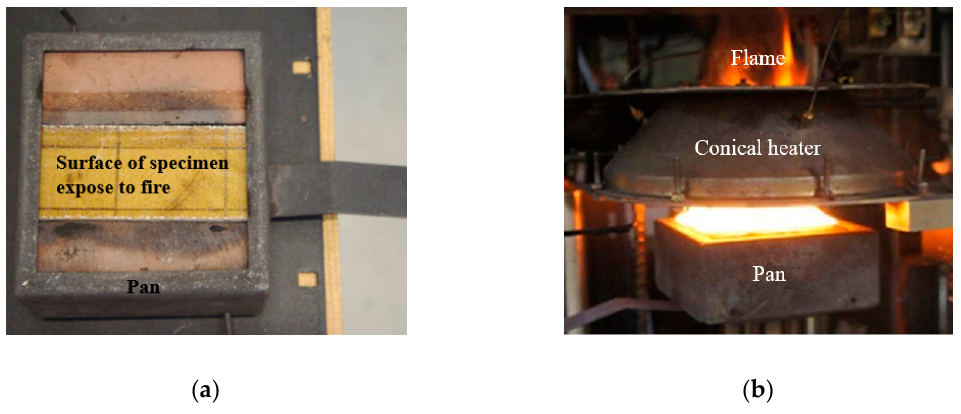
Figure 2. Diagram of the ATLAS cone calorimetry: holder of the test specimen ( a ), conical heater ( b ).